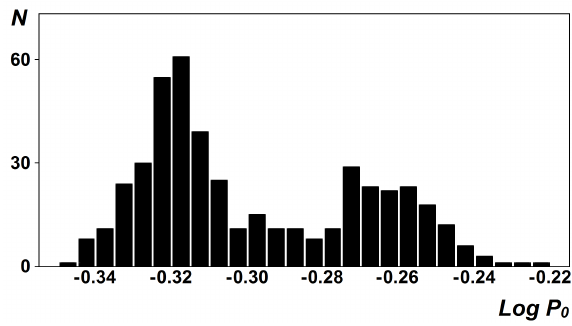
Fig. 3. The period distribution of RR(B)